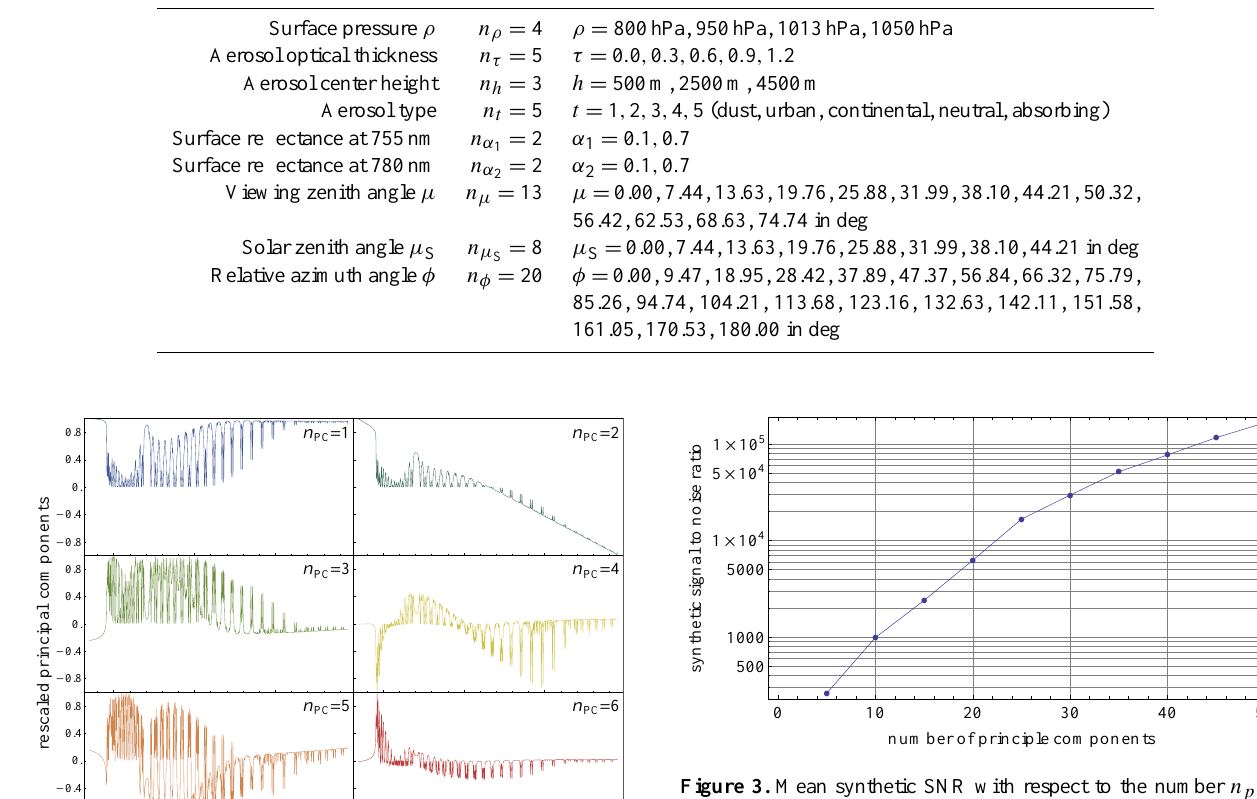
Figure 3. Mean synthetic SNR with respect to the number n p of principal